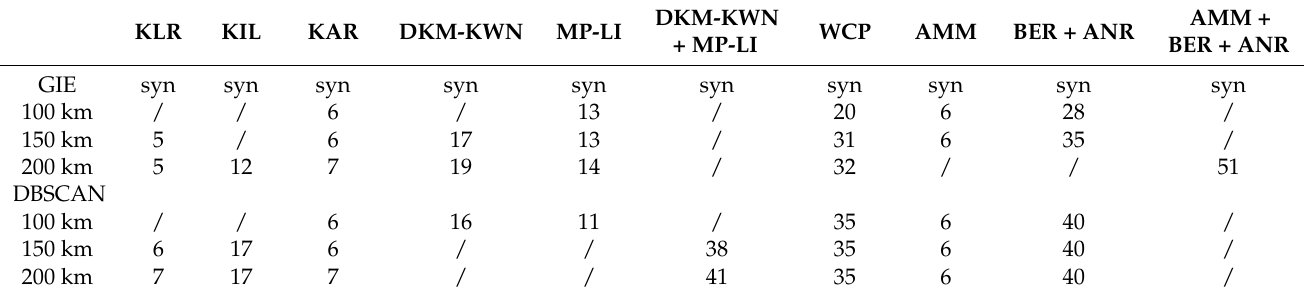
Figure 9. Areas of endemism detected by DBSCAN using the distance between centroids to 200 km and species with distribution range up to 100, 300, and 500 km. Table 2. Maximum number of sinendemisms for AoE by GIE and DBSCAN. Please refer to paragraph 2.2 for the names in full of Areas of Endemism reported in the first